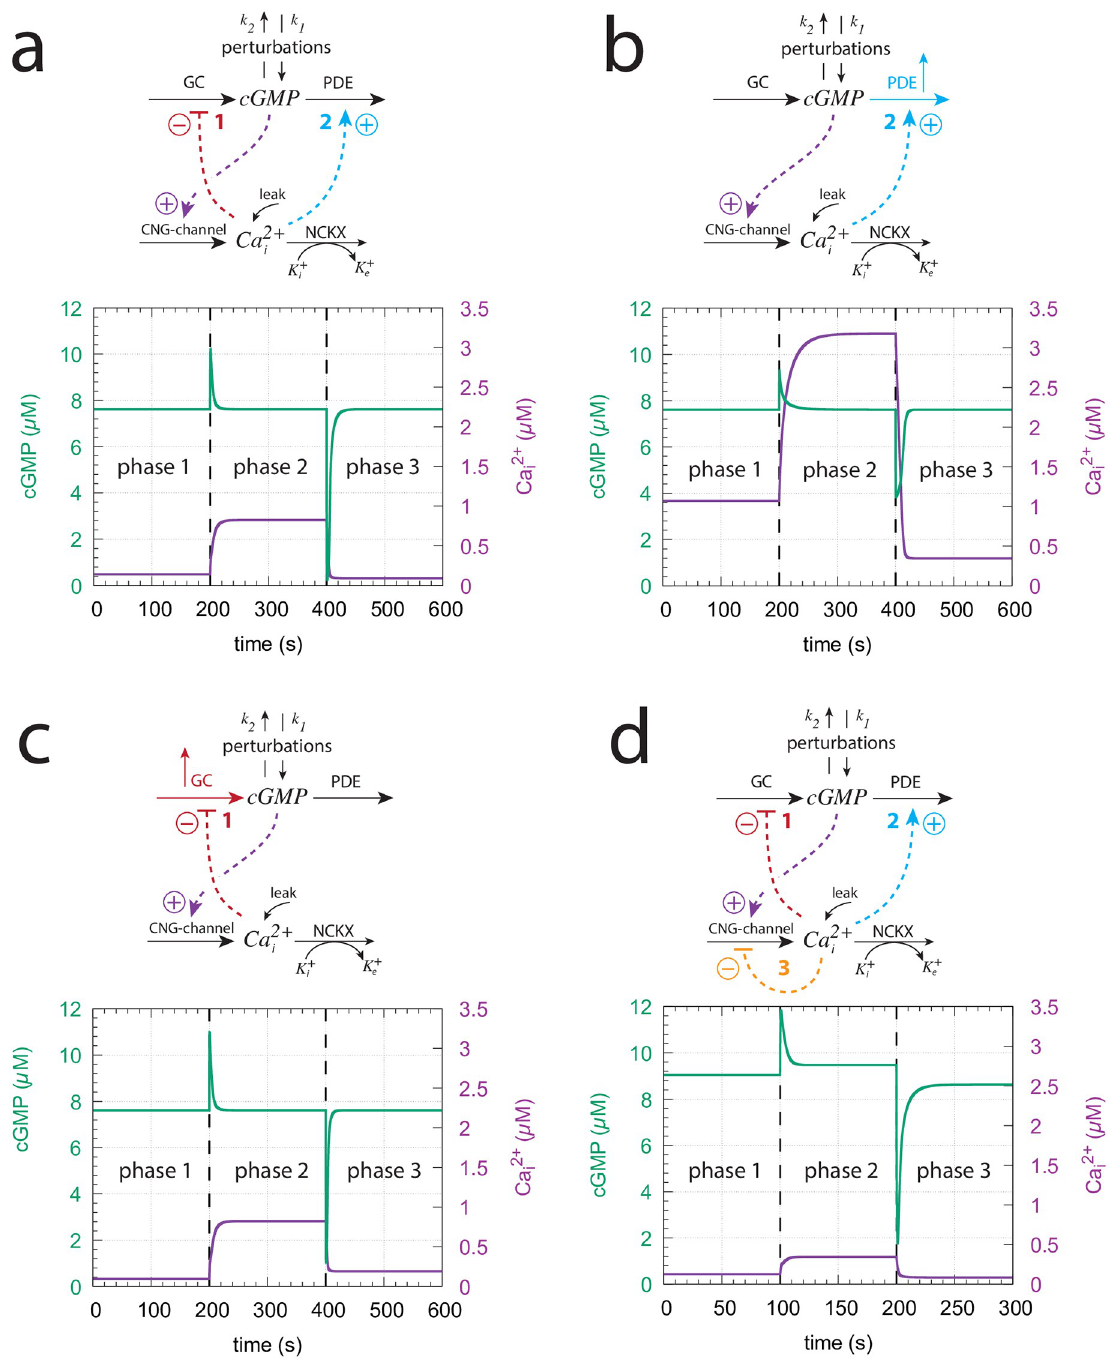
Fig 19. Influence of the model’s three feedback loops on the homeostatic behavior of cGMP and Ca 2 þ . Perturbation profile in panels i (a)-(d): phase 1: k 1 =0.0 μ M/s, k 2 =1.0s − 1 , k 4 =0.0s − 1 ; phase 2: k 1 =7.0 μ M/s, k 2 =0.0s − 1 , k 4 =0.0s − 1 ; phase 3: k 1 =0.0 μ M/s, k 2 =7.0s − 1 , k 4 =0.0s − 1 . (a) Both feedback 1 and 2 are operative. Robust homeostasis of cGMP is observed with cGMP set = 7.61 μ M. Other rate constants values are as described in section “Estimation of model parameters”. Initial concentrations: cGMP = 7.612 μ M, Ca 2 þ ¼ 141 : 7 nM , K + =1.760 μ M. (b) i Feedback 2 is only operative. In order to keep cGMP at its set-point k 4 needs to be increased to 8.0 μ M/s in all three phases (indicated in the scheme by the blue upright arrow). Initial concentrations: cGMP = 7.612 μ M, Ca 2 þ ¼ 1 : 071 m M , K + =2.335 μ M. (c) Feedback 1 is only i operative. To keep cGMP at its set-point k 3 has been increased from 50.0 μ M/s to 500.0 μ M/s in phase 3 (indicated in the scheme by the red upright arrow). Initial concentrations: cGMP = 7.612 μ M, Ca 2 þ ¼ 94 : 9 nM , K + =2.64 μ M. (d) All feedback loops are operative with rate i constants as in panel (a). Although perfect adaptation in cGMP is lost both cGMP and Ca 2 þ undergo only small variations when the i perturbations are applied with lowest Ca 2 þ levels. Initial concentrations: cGMP = 9.042 μ M, Ca 2 þ ¼ 125 : 7 nM , K + =1.989 μ M. See S4 Text i i how the leak term affects this